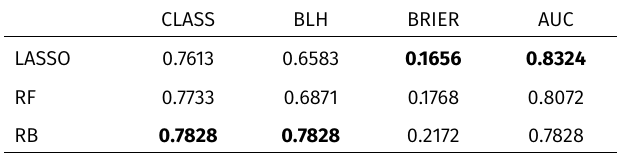
Table 4. Results of cross validation for alternative models without the player’s strength variable. Labels are identical to Table 3. CLASS BLH BRIER AUC LASSO 0.7613 0.6583 0.1656 0.8324 RF 0.7733 0.6871 0.1768 0.8072 RB 0.7828 0.7828 0.2172